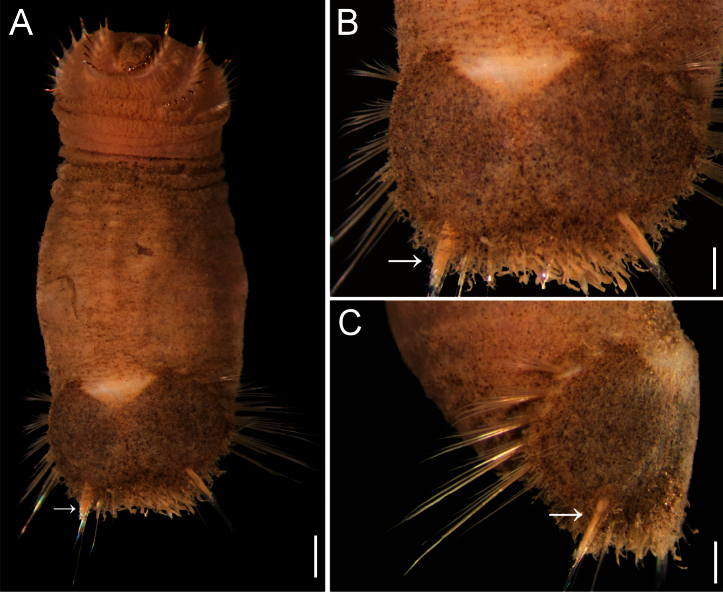
Caulleryaspis gudmundssoni sp. n., holotype (IMNH 10280) A Ventral view (arrow points peg chaetae) B Same, ventro-caudal shield (arrow points peg chaetae) C Same, posterior region, lateral view (arrow points peg chaetae). Bars: A 1.4 mm, B 0.8 mm C 0.9 mm (Photos: Gudmundur Vidir Helgason).